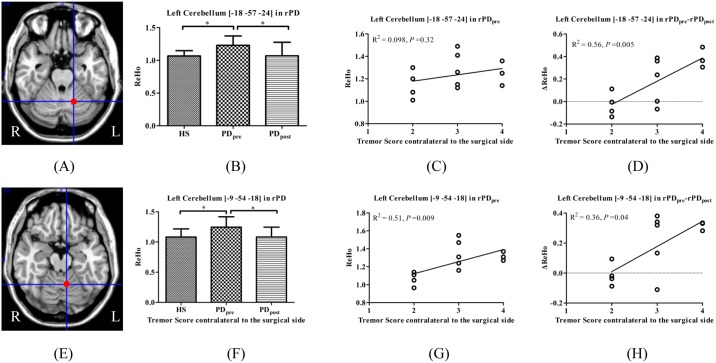
Brain areas which showed significant ΔReHo in PDpost versus PDpre and correlated with tremor.(A) left cerebellum_6 in rPD; (E) left cerebellum_4_5 in rPD; (B, F) ReHo among HS, PDpre, and PDpost; (C, G) ReHo in PDpre correlated with tremor; (D, H) ΔReHo correlated with tremor.